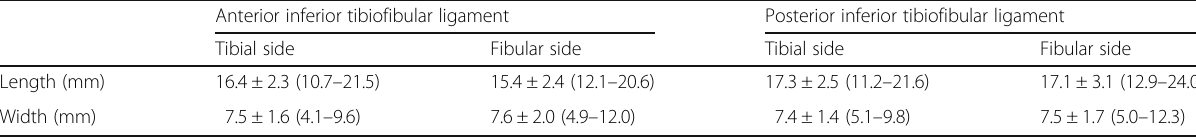
Table 1 Lengths and widths of the insertion sites of the anterior inferior tibiofibular ligament and posterior inferior tibiofibular ligament Anterior inferior tibiofibular ligament Posterior inferior tibiofibular ligament Tibial